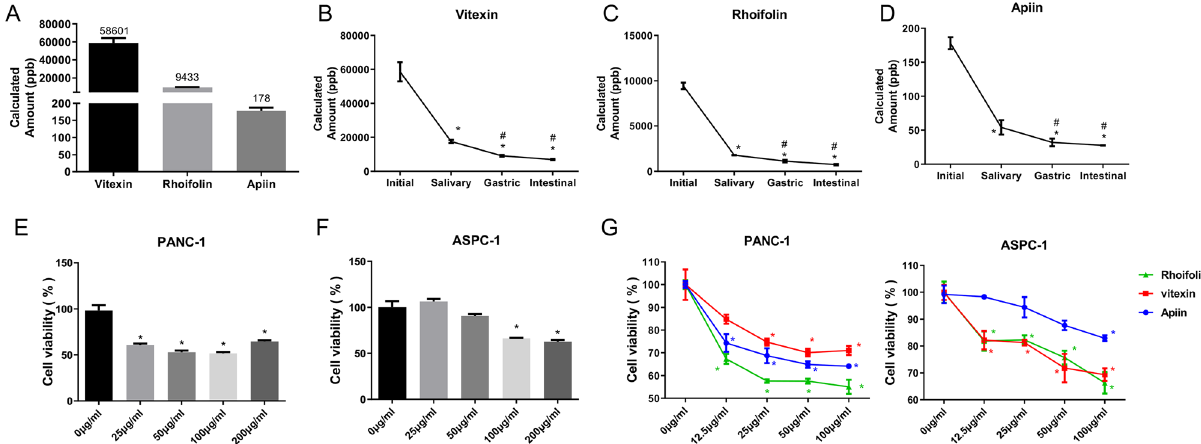
Figure 1. Rhoifolin might be a key effect component of total flavonoids. (A) The content of vitexin, rhoifolin, and apiin in the initial state. Calculated amount of vitexin (B) , rhoifolin (C) , and apiin (D) in plumula nelumbinis with simulated digestion of total flavonoids with salivary solution, gastric solution, and intestinal solution. Cell proliferation analysis in PANC-1 (E) and ASPC-1 cells (F) were treated with 0, 25, 50, 100, and 200 μg/ml total flavone. (G) Cell proliferation analysis in PANC-1 and ASPC-1 cells were processed with 0, 12.5, 25, 50, and 100 μg/ml vitexin, rhoifolin, and